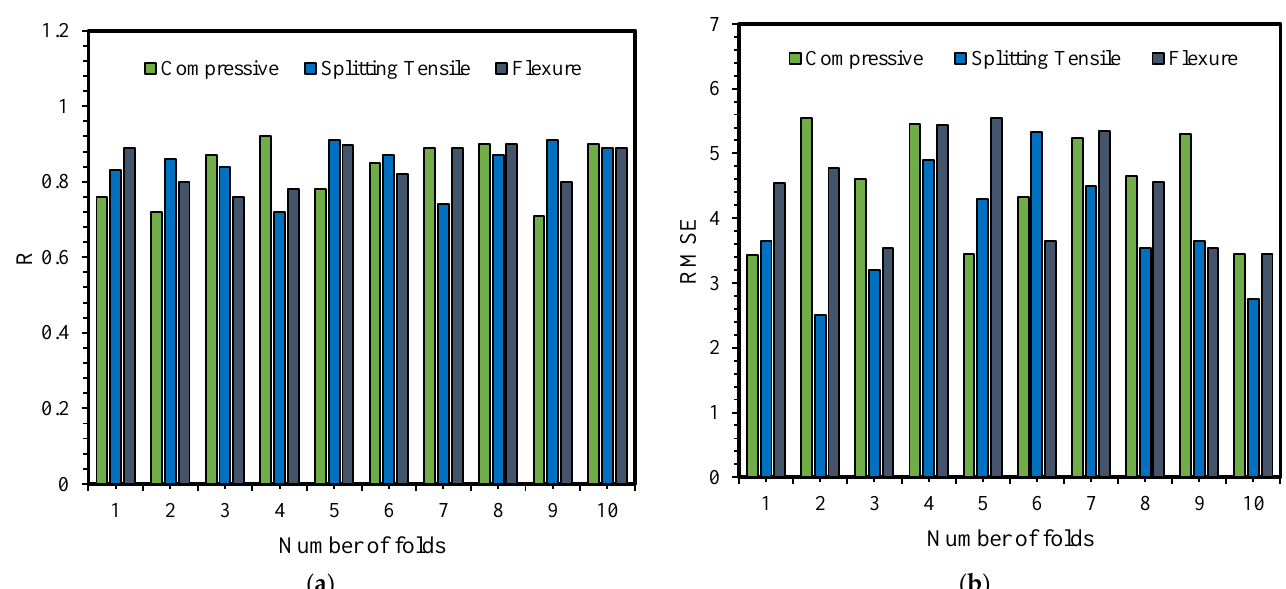
Figure 10. Cross-validation result of the developed models based on ( a ) R and ( b ) RMSE values.